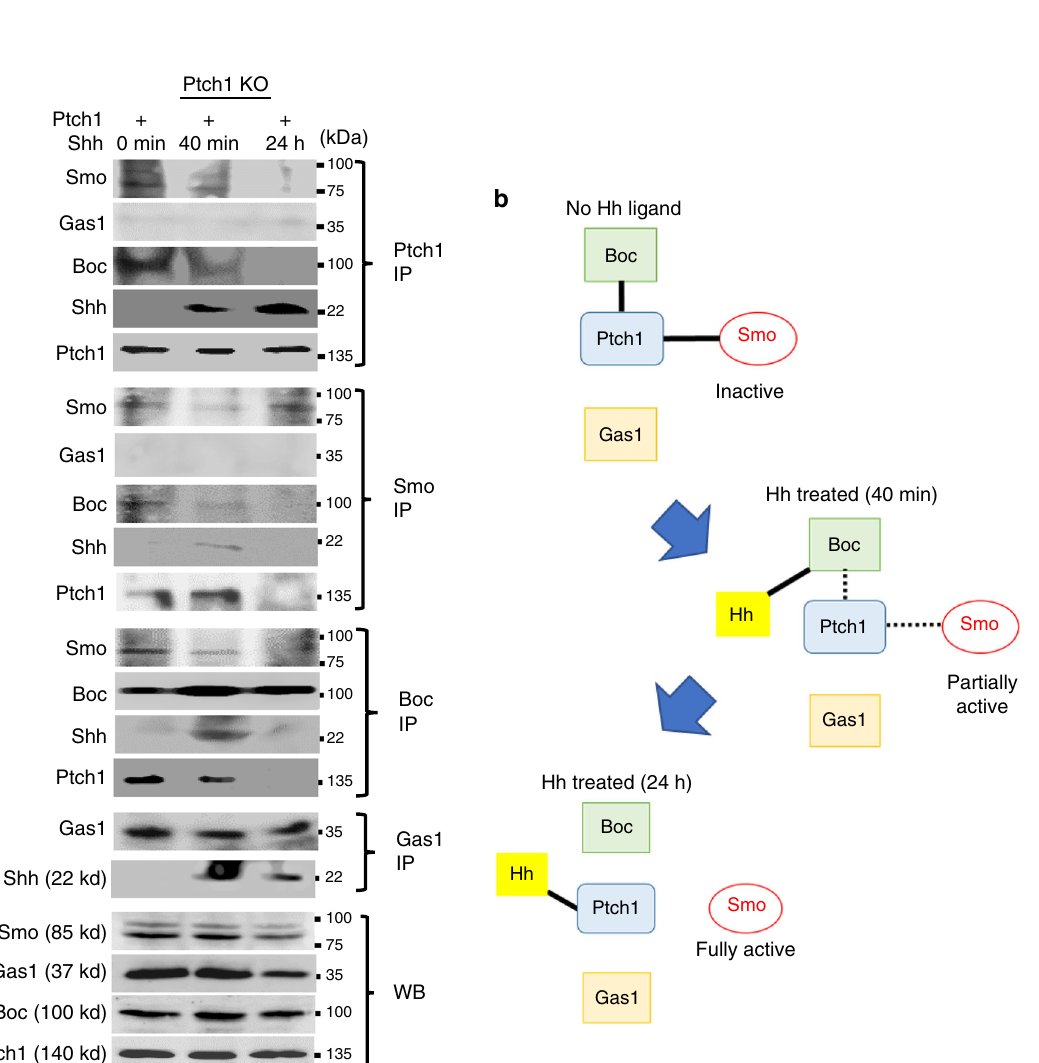
Fig. 6 Gas1 mediates Hh ligand reception by Ptch2. a Representative images of at least two independent immunoblotting experiments in which NIH3T3/ Cas9 cells with Ptch1 KO were transfected with Myc-tagged Ptch2 expression construct and stimulated with Shh protein in serum-free medium for 40 min. Interactions of Ptch2 with endogenous Smo, Gas1 and Boc were analysed by immunoprecipitation (IP) and Western blotting (WB). IP was performed using speci fi c antibodies as indicated and analysed by WB with respective antibodies as shown. The images in the bottom panel are from Ptch1 KO cells transfected with empty vector, which did not show any co-precipitation of endogenous Gas1 and Ptch2 regardless of Shh treatment, con fi rming the speci fi city of these antibodies (bottom panel). b A schematic diagram illustrating the protein interactions before and after Shh treatment. c NIH3T3/Cas9 cells with Gas1 KO were transfected with Myc-tagged Ptch2 and stimulated with Shh protein in serum-free medium for 40 min. IP was performed with anti- Myc antibody. Representative blots from two independent experiments are shown. d A schematic diagram illustrating the protein interactions in Gas1 KO cells. Source data are provided as a Source Data fi le.